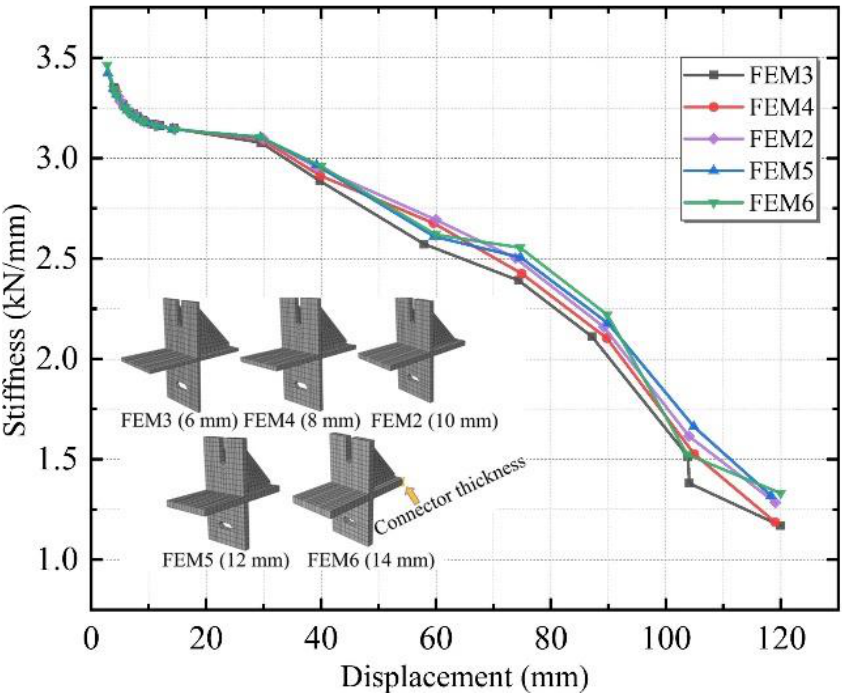
Figure 17. Stiffness degradation curves with different specimen thicknesses.